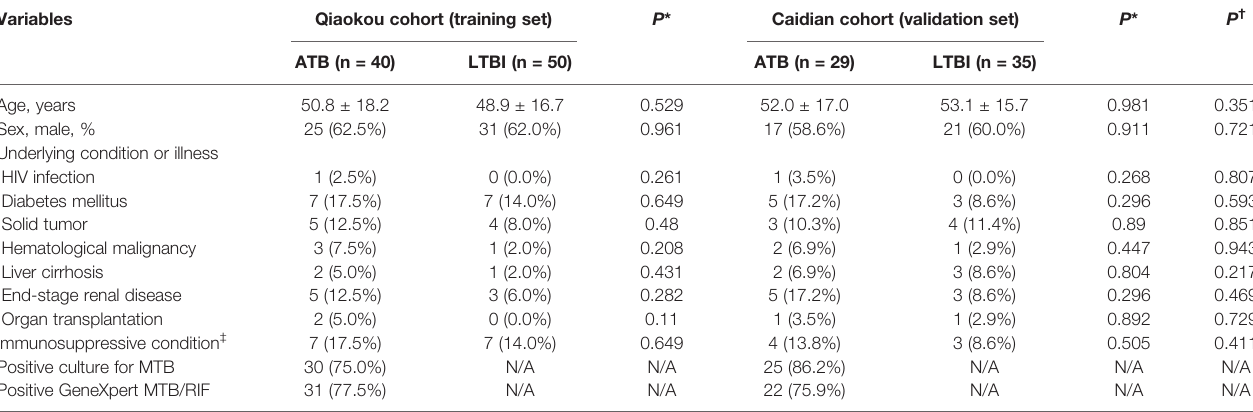
TABLE 1 | Demographic and clinical characteristics of study population.